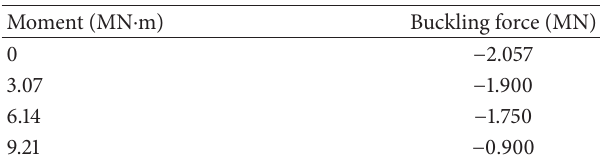
Table 7: Critical buckling compressive force versus end moment; cantilevered boundary